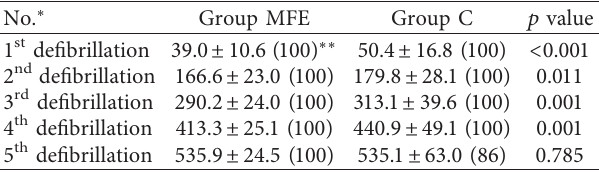
Table 2: Time of consecutive applications of